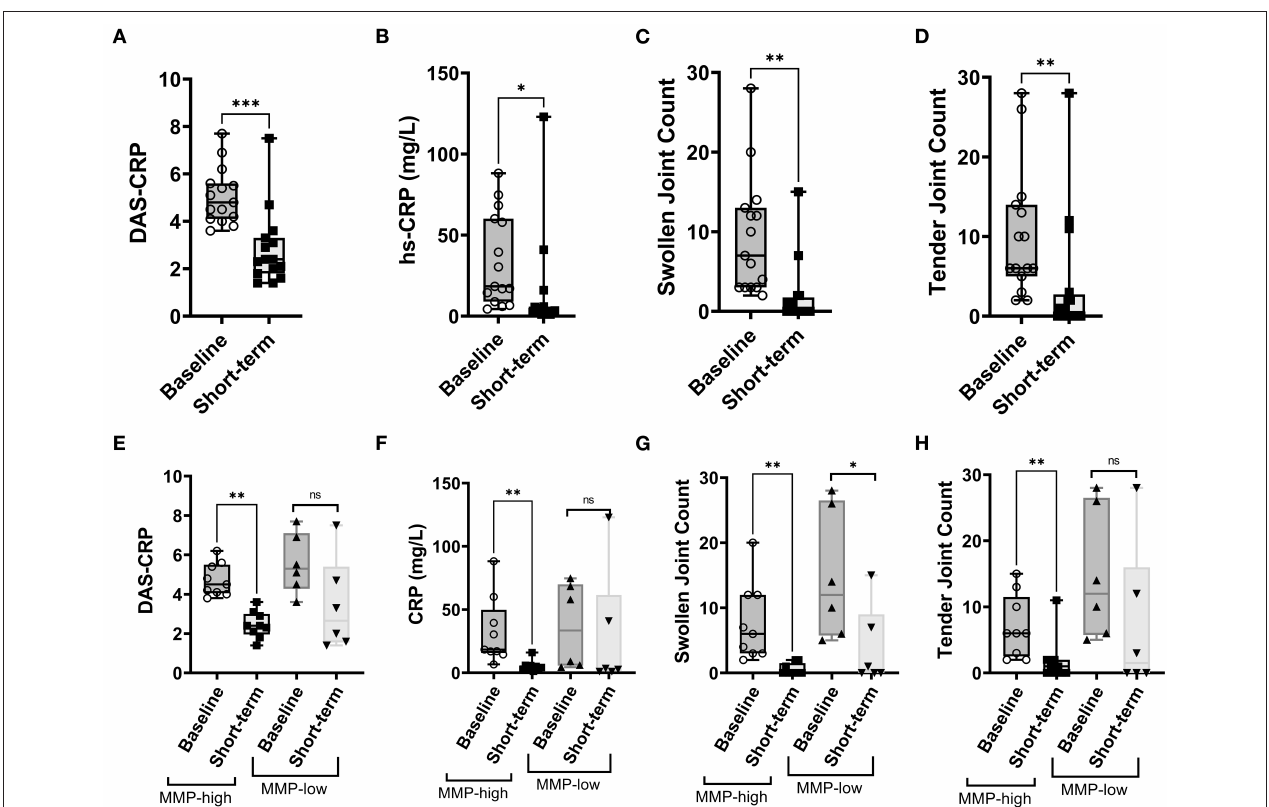
FIGURE 4 | Analysis of short-term clinical outcomes in DMARD-naïve EIA patients – (A–D) Box-whiskers plot showing DAS-CRP, hs-CRP levels (represented as mg/L), swollen joint count and tender joint count at baseline and short-term follow-up interval. Data was analyzed by Mann-Whitney test. *** P < 0.001, * P < 0.05